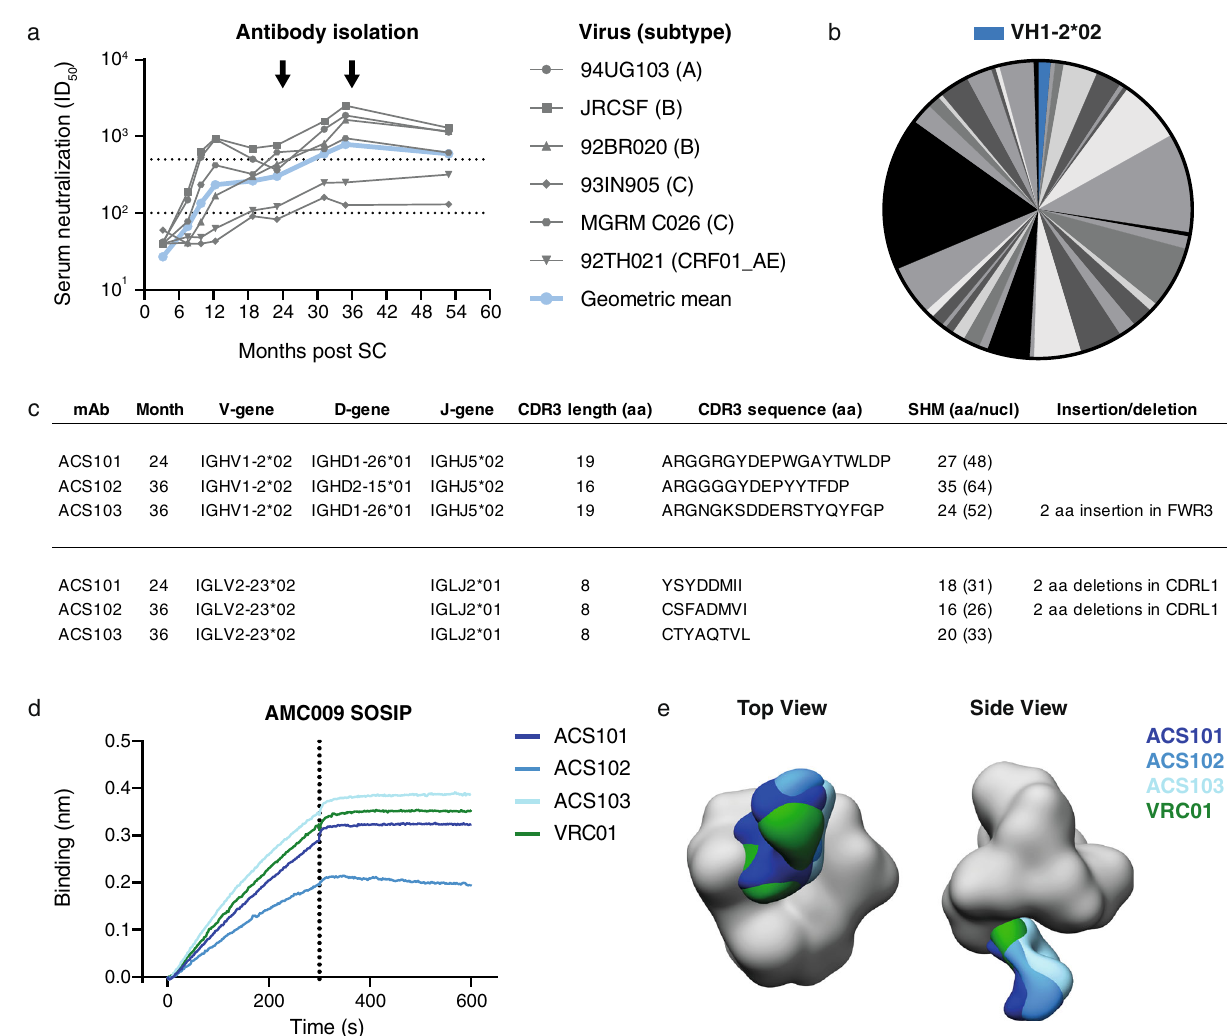
Fig. 1 | Isolation and characterization of VH1-2-derived mAbs with average- lengthCDRL3thattargettheCD4bs.a Longitudinalserumneutralization(serum dilution that inhibits 50% of viral infectivity (ID 50 )) of donor H18877 against a multiclade virus panel. The geometric mean is represented as a blue line. Serum samples were obtained at 3.2, 7.5, 9.8, 12.3, 18.8, 25.0, 31.2, 34.9, 52.8 months post SC, whilePBMCs were isolatedatmonth 24.0 and 36.0 post SCasindicated by the black arrows. b Pie-chart of VH gene usage of isolated B cells from months 24 and 36 post SC ( n =222). Each gray-color coded slice represents a certain VH gene and the slice size is proportional with the amount of BCRs derived from this particular VH gene. BCRs using the VH1-2*02 gene are colored in blue. c Sequence